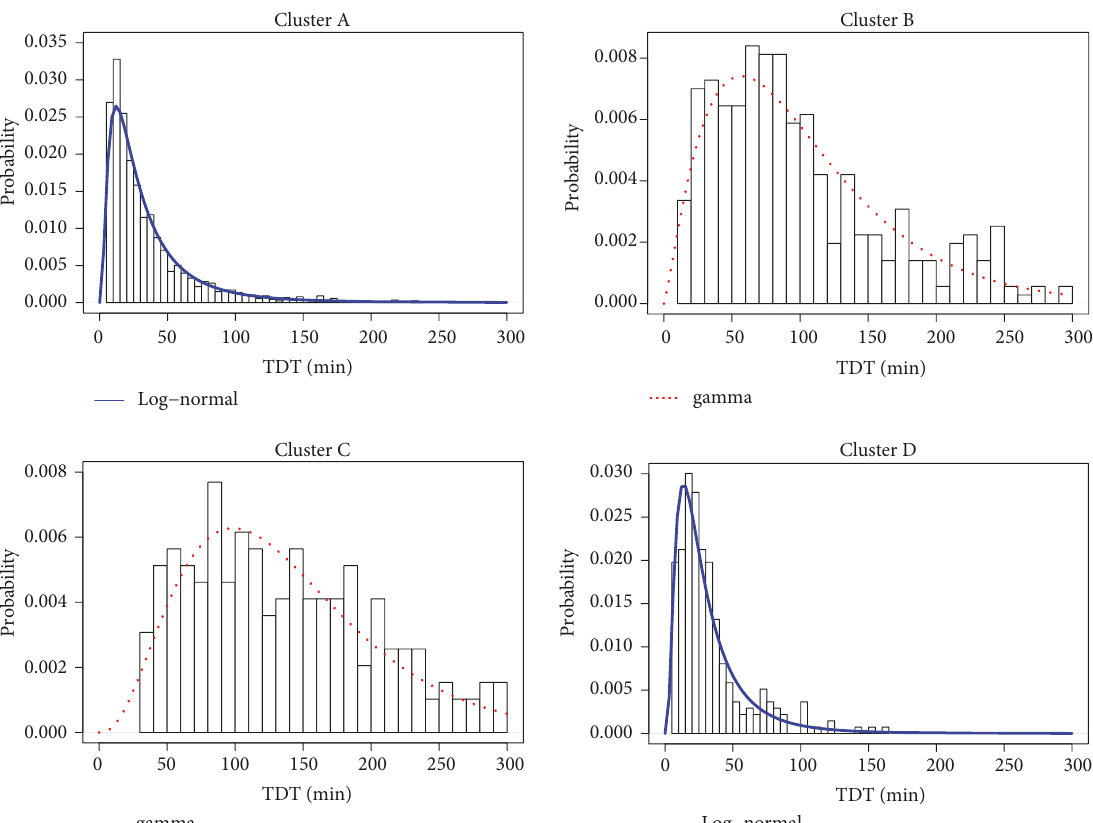
Figure 10: Fitting results of TDT on testing